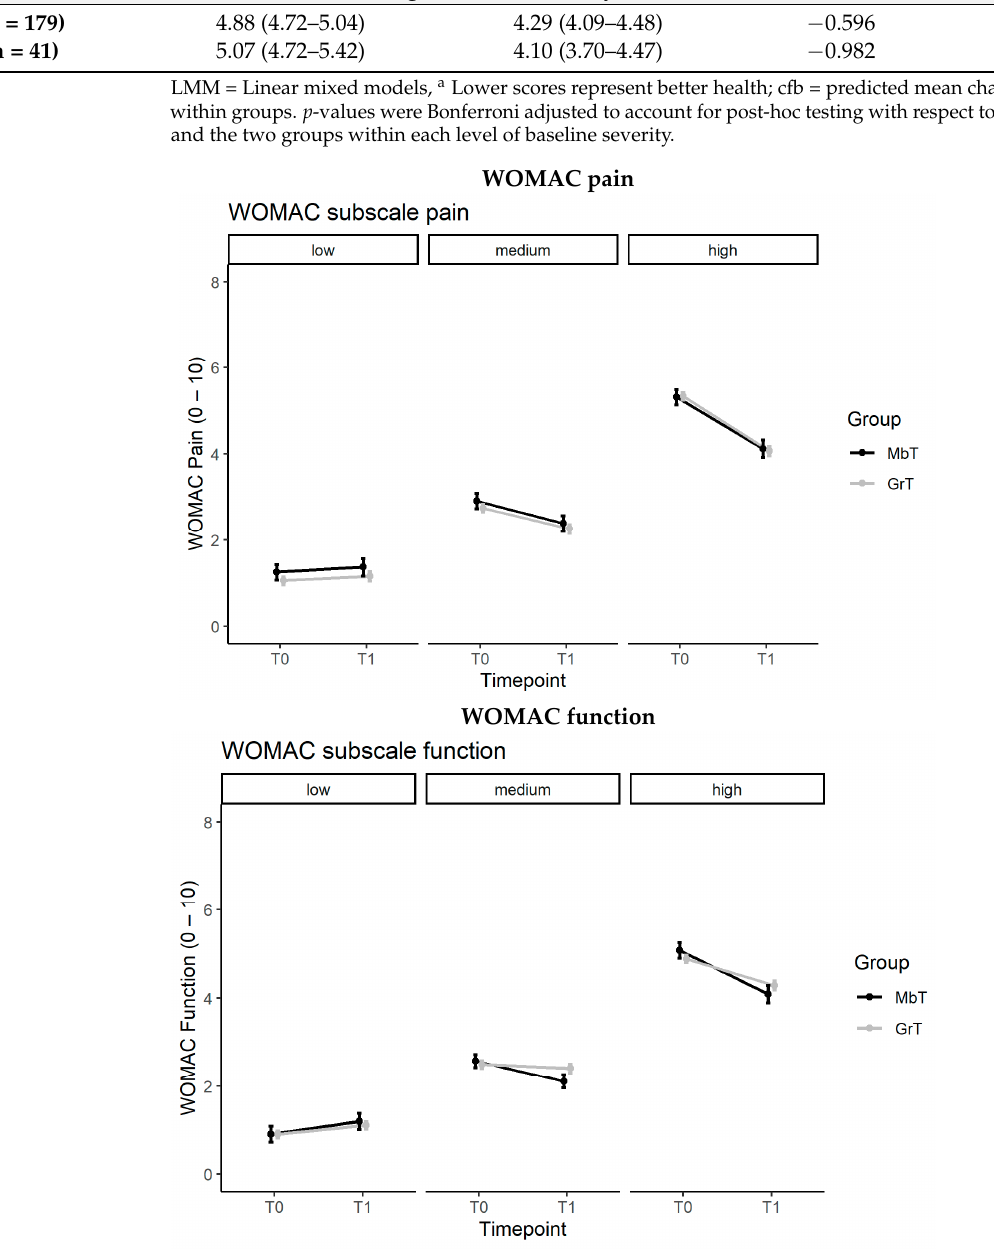
Figure 2. Estimated marginal means (SE) WOMAC pain/function scores in GHT and MbT at baseline T0 and post-intervention T1. GHT = Group-/home-based training, MbT = Machine-based training. Adjusted Models (Time, Treatment, Time*Treatment, Age, Sex, BMI, OA site, Artificial joint replacement). Lower scores represent better health.